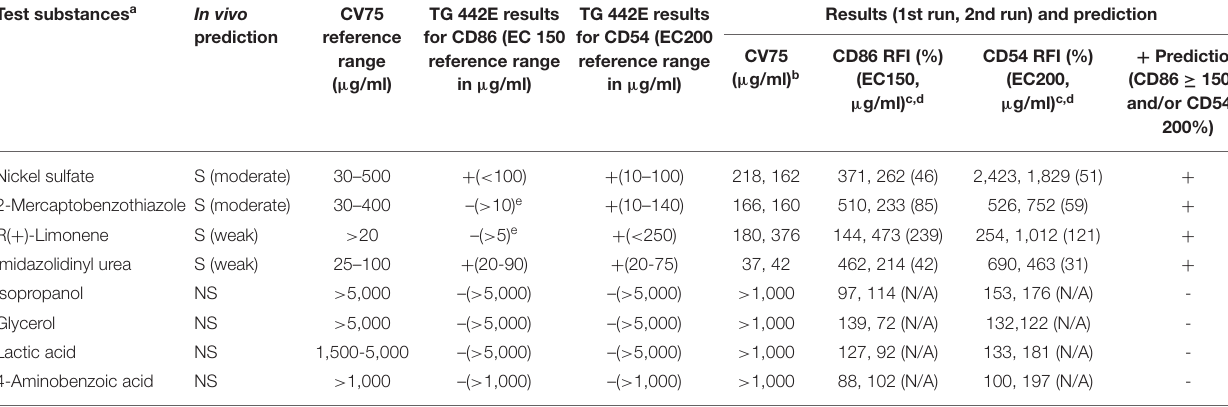
TABLE 1 | Proficiency test results of eight recommended substance in the OECD TG 442E for h-CLAT assay. Test substances a